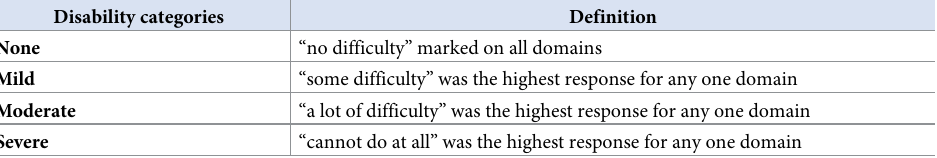
Table 2. Definition of disability